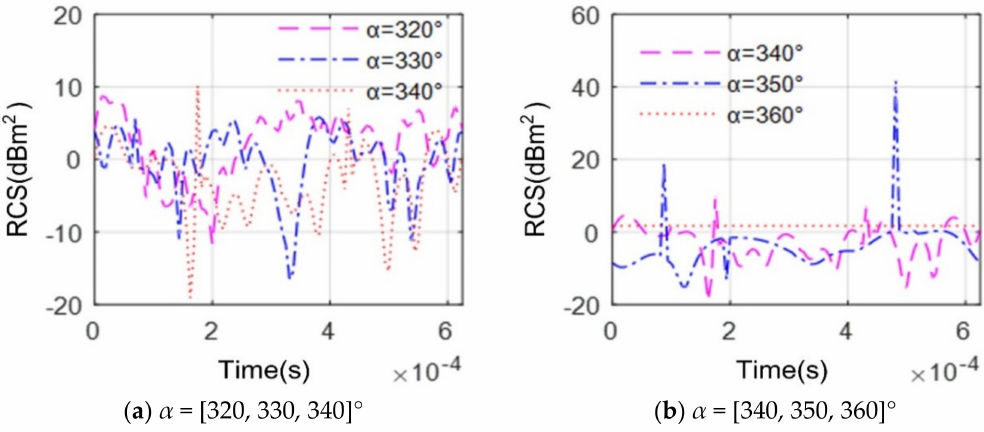
Figure 10. Influence of azimuth on dynamic RCS of m fan , α = 320 ◦ ~360 ◦ , N obs,fan = 1, and β = 0 ◦